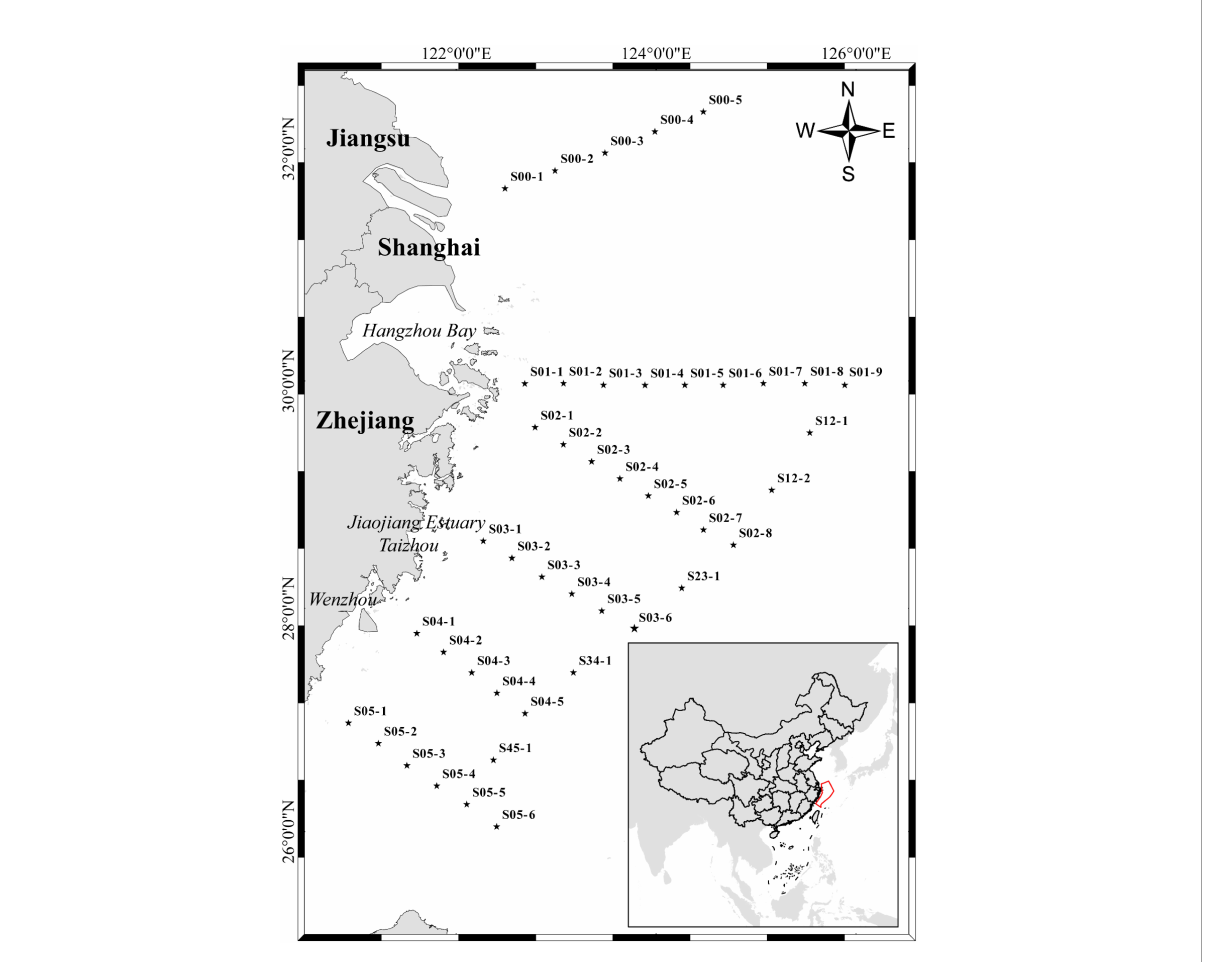
FIGURE 1 Map of the study area and sampling locations. The star point represents the station. The station name is marked in the top right corner of each station. Pentagrams indicate